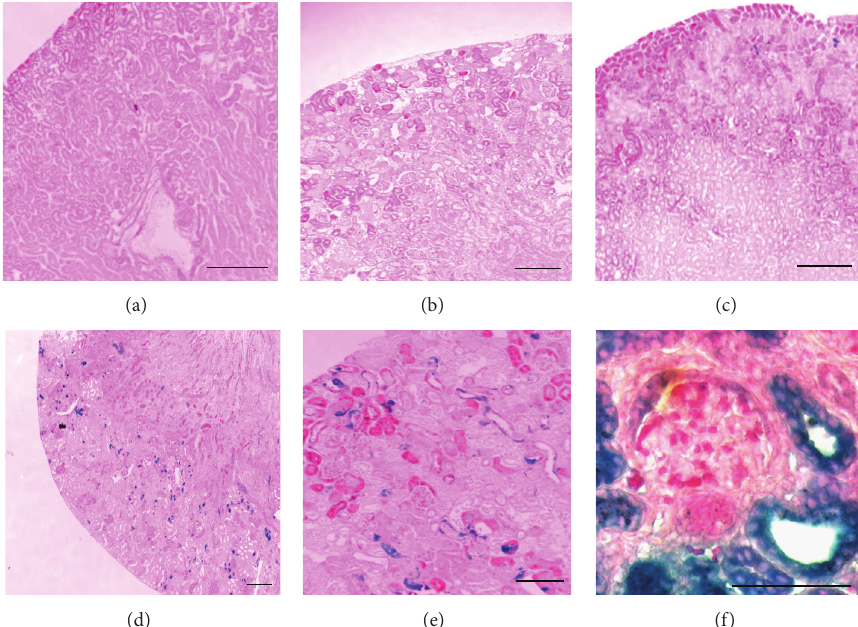
Figure 1: Endogenous 𝛽 -catenin/TCF reporter transgene activity following glycerol-induced renal tubular injury in adult mice. (a and b) No 𝛽 -galactosidase signal is seen in uninjured or glycerol-treated mouse kidneys of CD1 wild-type mice. (c) 𝛽 -galactosidase signaling is minimal in the uninjured 𝛽 -catenin/TCF reporter mouse kidney. (d–f) Strong 𝛽 -catenin/TCF reporter activity (X-Gal, blue) is seen in renal tubules of adult mouse kidney 3 days after glycerol-induced renal injury. Scale bars: 50 𝜇